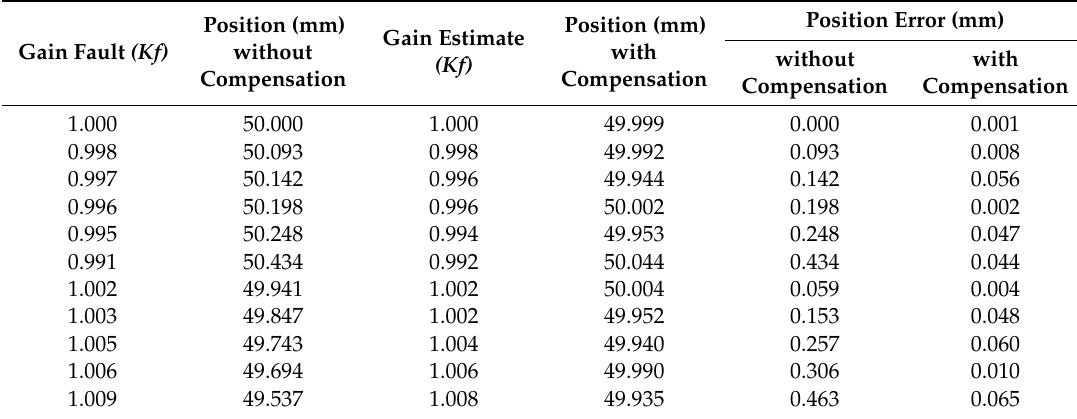
work table position of all three groups: the blue line is the setting position with a response of 50 mm, and the other two lines show the response of the work table without gain compensation and with gain compensation as orange and grey lines, respectively. The summary of the gain compensation result was shown in Table 5. The average position error of the worktable of the system without gain compensation was 0.228 mm, while the average position error of the system with gain compensation was shown to be 0.017 mm. The result was that the system with gain compensation was shown to be e ff ective, reducing the position error by